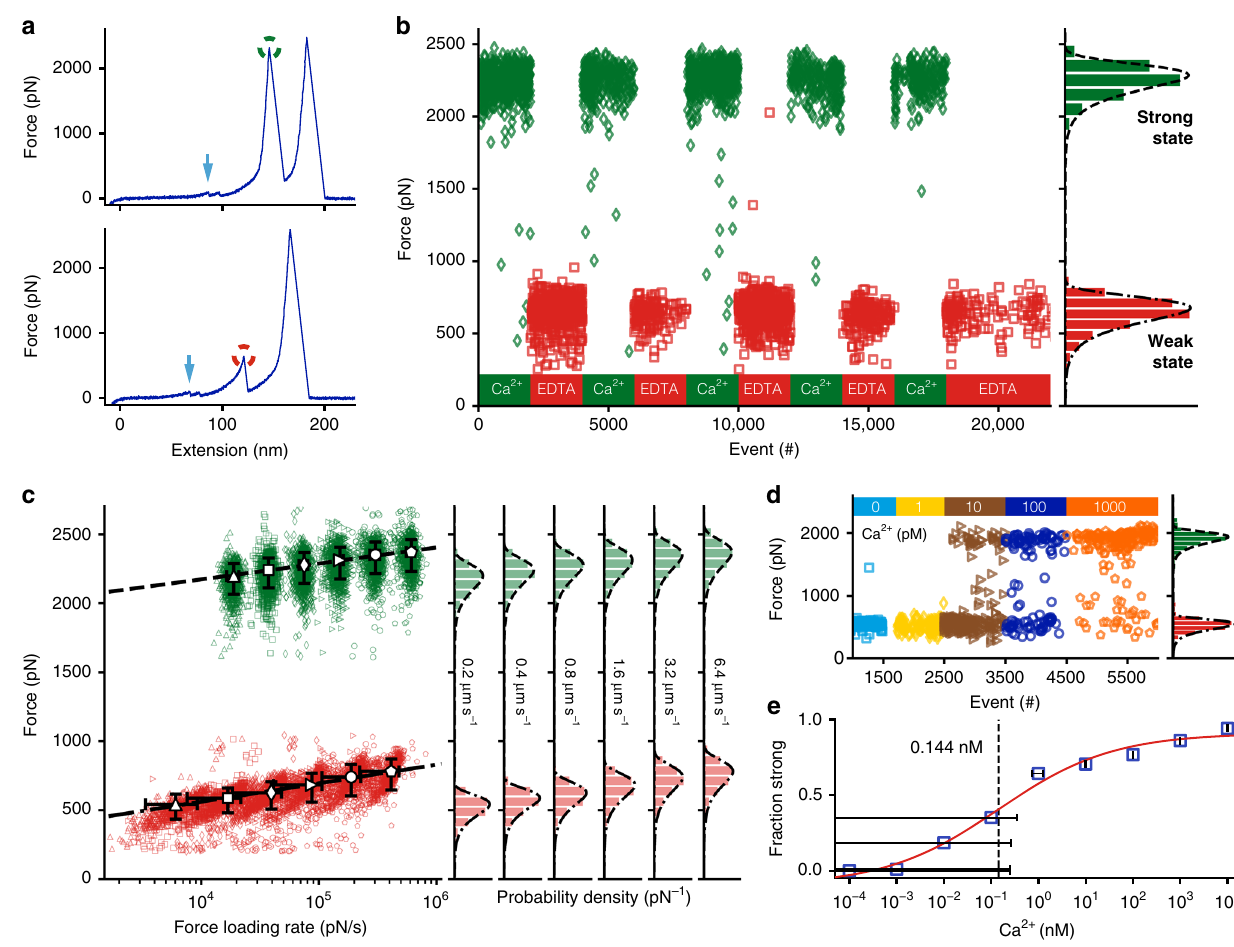
Fig. 2 B domain stability and unfolding force are governed by calcium. a SdrG B1 unfolds in 10 mM Ca 2 + at over 2 nN (strong state, green circle) and here at ~ 650 pN in the presence of 10 mM EDTA (weak state, red circle) at a retraction velocity of 1.6 µ m s − 1 , after ddFLN4 fi ngerprint unfolding (cyan arrows). b SdrG B1 domain stabilities can be cycled repeatedly by alternate application of Ca 2 + 10 mM (green diamonds) and EDTA 10 mM (red squares). c Dynamic force spectrum of the weak and strong state stabilities. Strong state (green) in 10 mM Ca 2 + : 0.2 µ m s − 1 (triangles, N = 848), 0.4 µ m s − 1 (squares, N = 1128), 0.8 µ m s − 1 (diamonds, N = 1162), 1.6 µ m s − 1 (forward triangles, N = 1202), 3.2 µ m s − 1 (circles, N = 1039), 6.4 µ m s − 1 (pentagons, N = 1129), BE fi